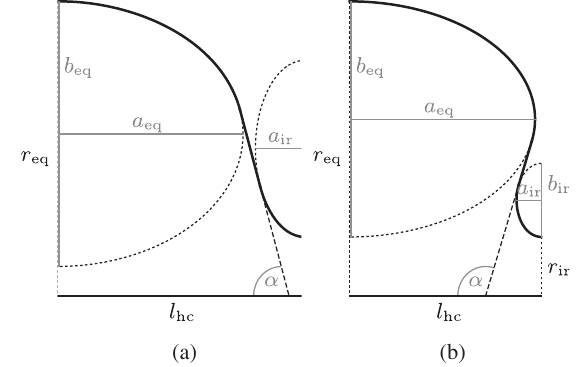
FIG. 2. Profile of elliptical half cells with equator radius r iris radius r and length l . The dotted lines subscribe the ir hc corresponding ellipses as well as the connecting straight with